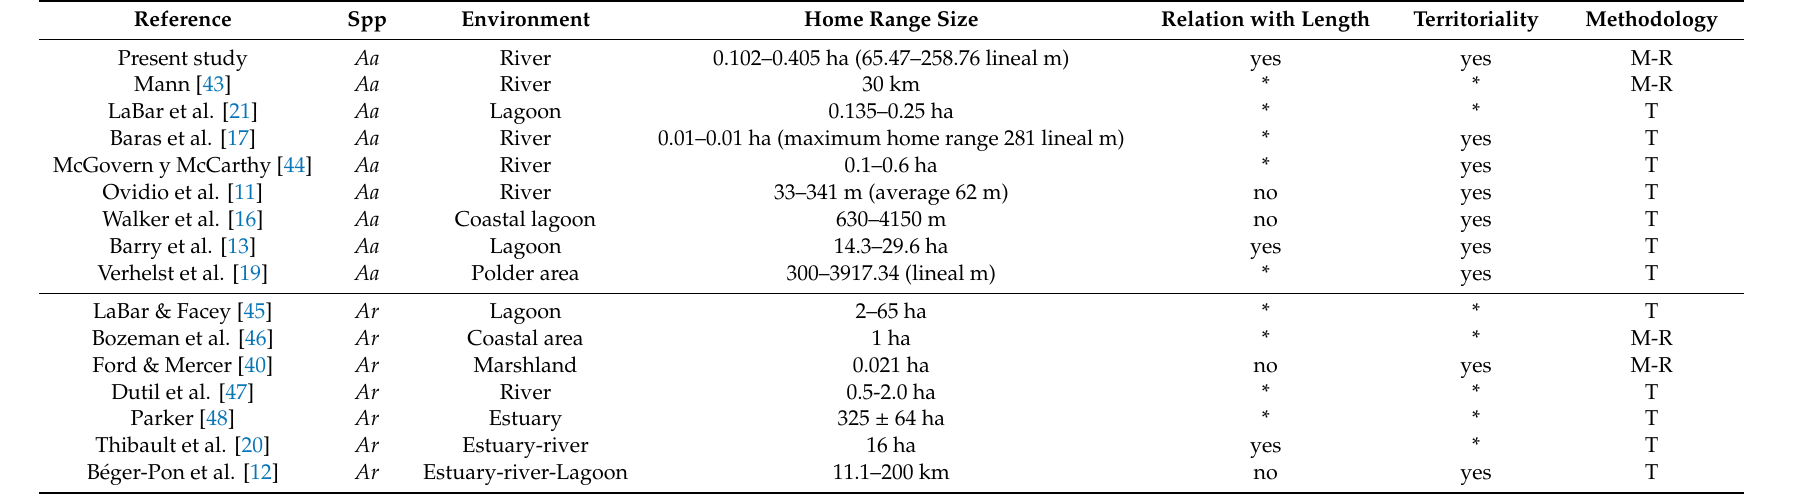
Table 4. Home range size of di ff erent European eel ( Aa ) and American eel ( Ar ) populations. M-R: mark-recapture; T: